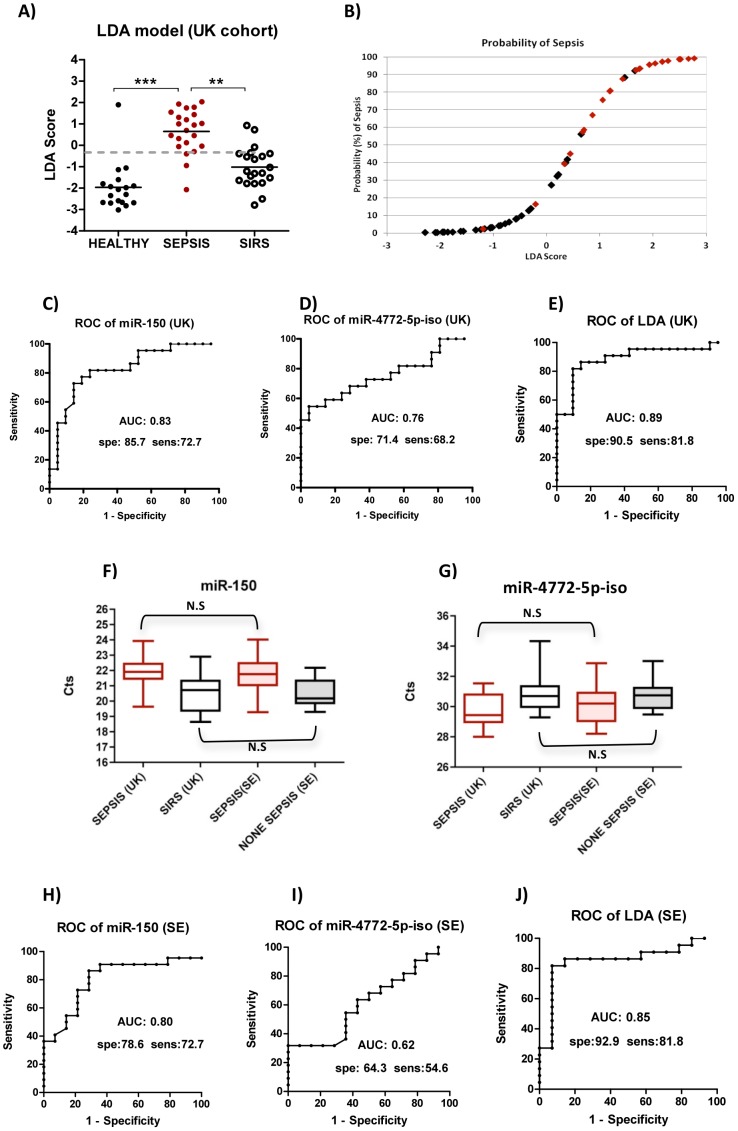
Construction and Validation of a Linear Discriminant Model for diagnosing sepsis from SIRS.(A) LDA score was achieved using linear discriminant analysis (LDA) based on results of miR-4772-5p-iso and miR-150 in UK cohort; Mann-Whitney U test were applied. *** significant at p<0.001; (B) Prediction plot based on LDA score (X axis) and re probability of sepsis (Y axis), Red dots: Sepsis, Black dots: SIRS; ROC Curves demonstrate the diagnostic capacities of (C) miR-150 alone, (D) miR-4772-5p-iso alone and (E) LDA score; (F) miR-150 expression and (G) miR-4772-5p-iso expression of 2 patient groups from both UK and Sweden, Kruskal-Wallis ANOVA test was applied; ROC curves show the diagnostic power of (H) miR-150 and (I) miR-4772-5p-iso alone; (J) LDA score from Swedish cohort.